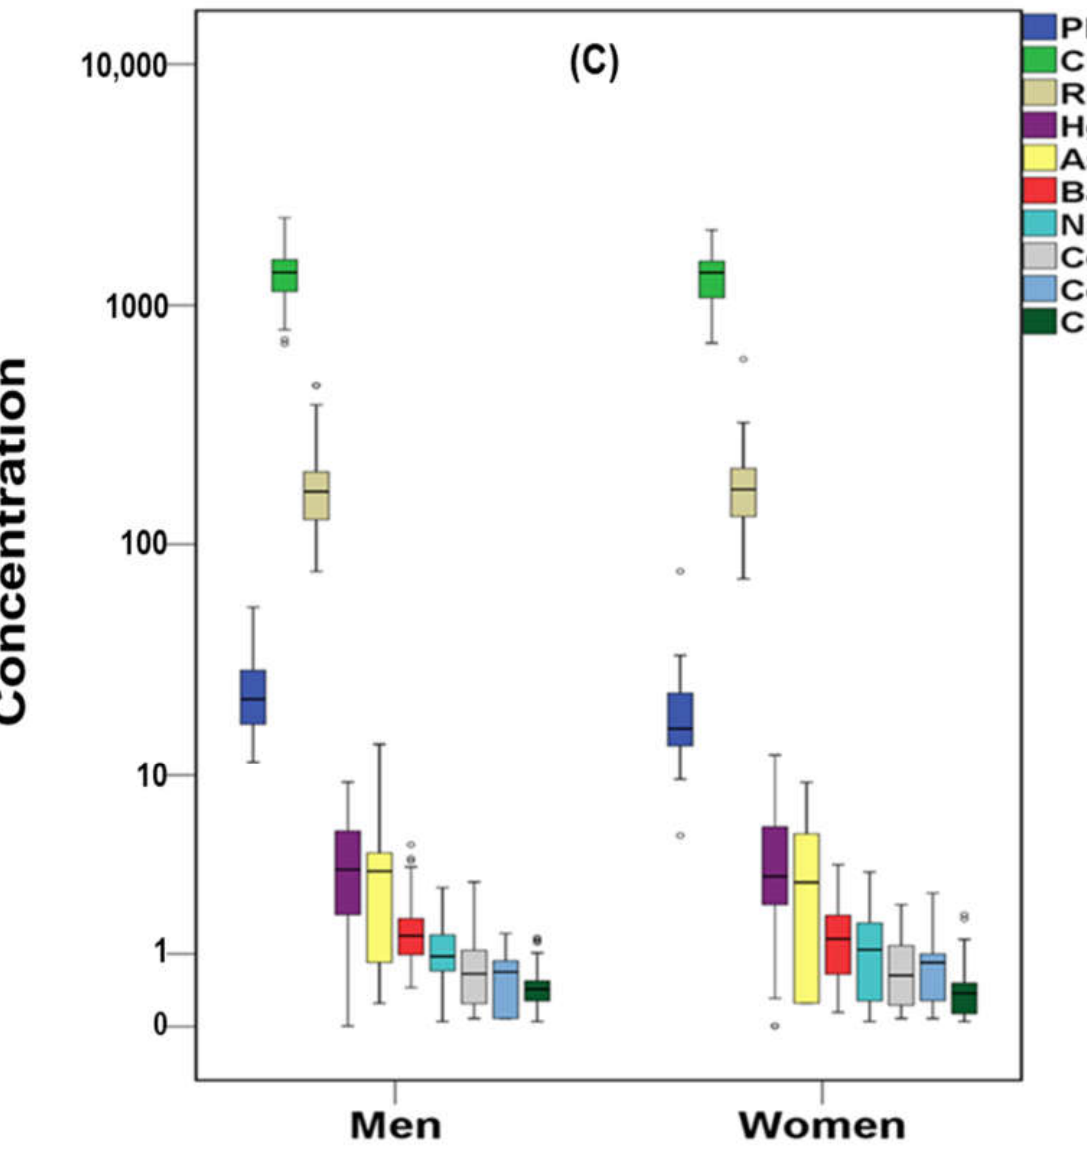
Figure 5. PAHs ( A ), OHPAHs ( B ), and trace elements’ ( C ) variation according to the gender of cases in μg L −1 ( + outliers and o values above 3rd quartile, * p < 0.05) in logarithmic scale (PHE:phenanthrene, BaA:benzo[a]anthracene, CHR:chrysene, FL:fluorene, ACE:acenaphthene, FLT:fluoranthene, DBA:dibenzo[a,h]anthracene, PYR:pyrene, NAP:naphthalene,